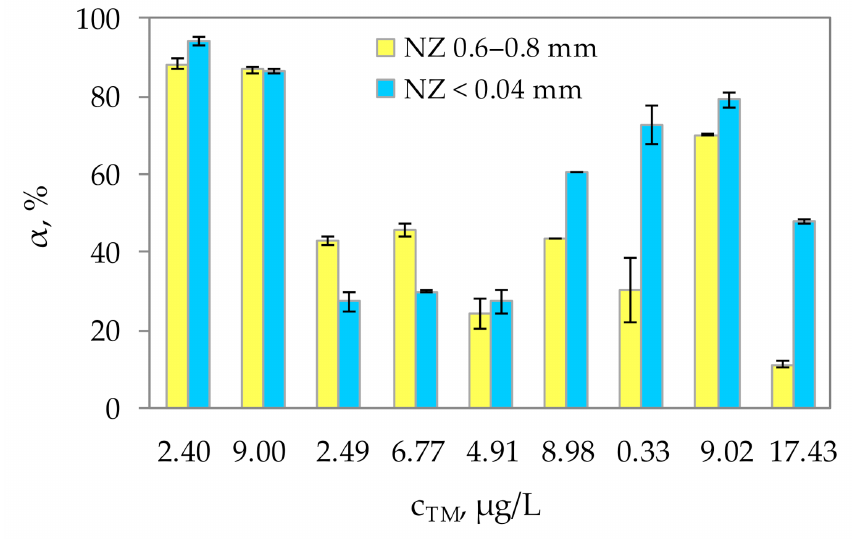
Figure 11. Removal efficiency (mean ± SD) of natural zeolite of two particle sizes toward total mercury in dependence on the initial concentration of total mercury